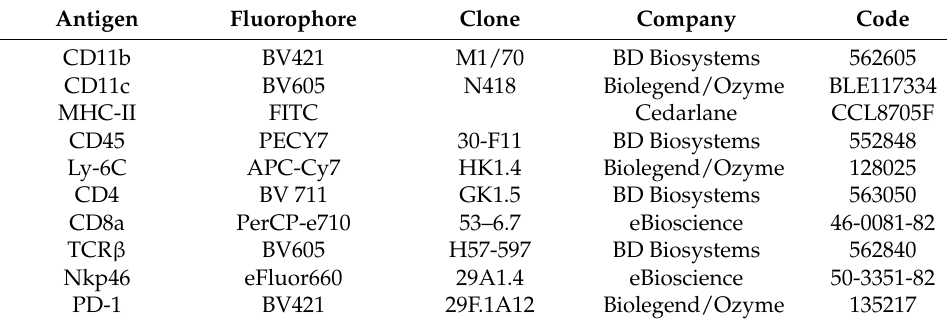
Table 1. List of antibodies used for cytometry